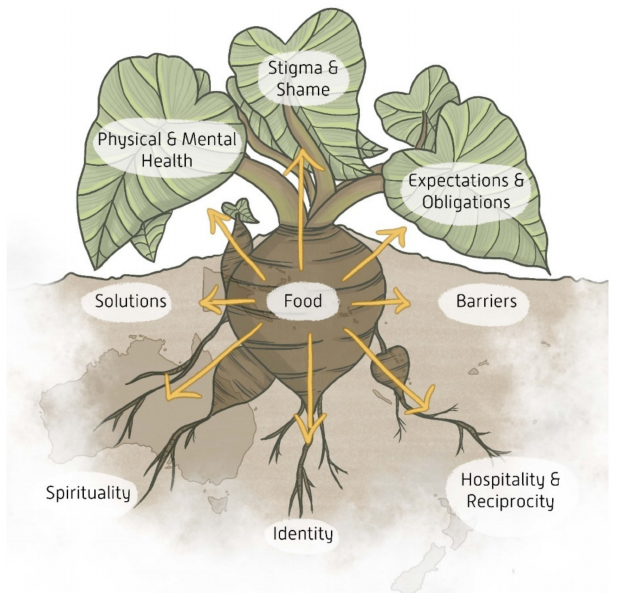
Figure 3. The taro plant illustrates eight key themes that emerged from the interviews which are shown to be all interconnected by food: identity, hospitality and reciprocity, and spirituality form the roots or foundation of the meaning of food for M¯aori and Pasifika peoples; solutions and barriers form the soil or structure from which these understandings and practices of food are nourished or restricted; physical and mental health, expectations and obligations, and stigma and shame form the leaves of the taro plant, representing the surface-level experiences and challenges of food insecurity. The diagram overlies a map of Australia, Aotearoa and some Pacific Islands to symbolise how our peoples’ experiences of food insecurity may differ between diasporic and homeland communities but are simultaneously intertwined by socio-cultural and genealogical ties that transcend space and